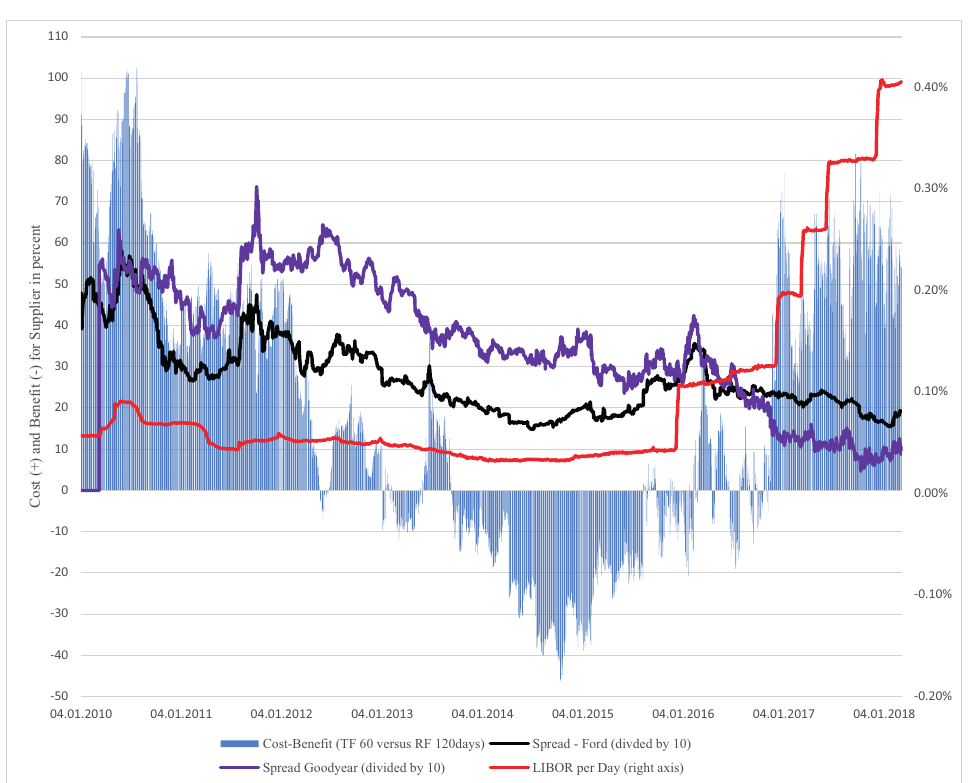
Figure 2. Simulation of cost and benefit trade-off in percent over the business cycle. The figure denotes the cost of reverse factoring in percent (60 vs. 120 days) in comparison to bank credit financing over 60 days (customer: Ford; supplier: Goodyear). Source: Authors’